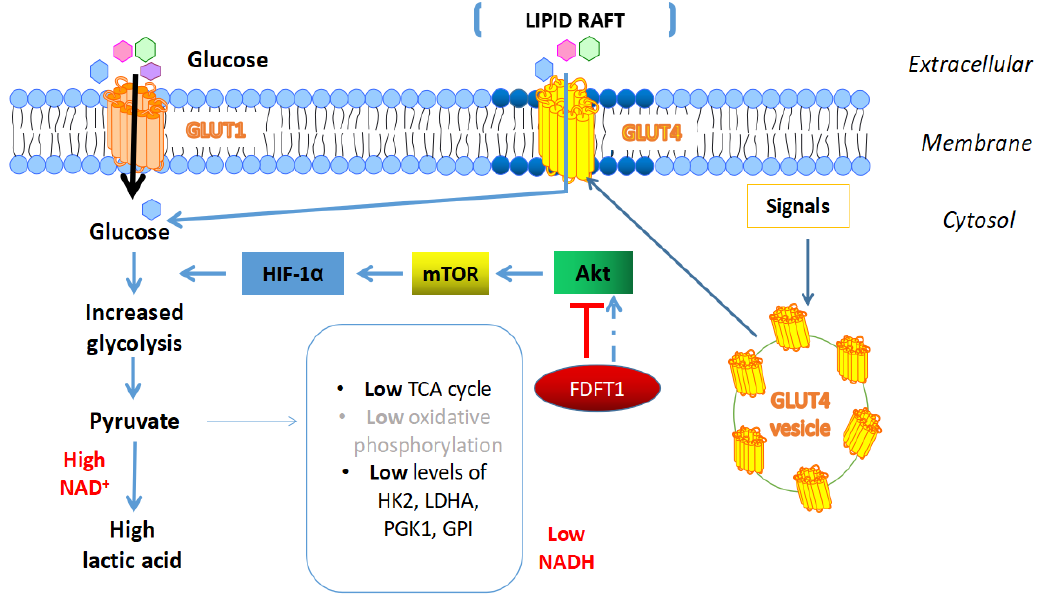
Figure 5. Association FDFT1 with metabolism in cancer. FDFT1 increases cholesterol in membrane microdomains, and thus traffics GLUT4 from the cytosol to lipid rafts in the cell membrane, consequently enhancing glucose uptake from TME into cells. On the other hand, FDFT1 has been determined to inhibit the Akt/mTOR/HIF-1 α axis, thereby decreasing expression of glycolytic enzymes such as HK2, LDHA, PGK1, GPI, and ultimately, reducing the lactic acid concentration in the TME. However, this mechanism has only been shown in colorectal cancer [7] , and it will be necessary, therefore, to determine whether FDFT1 could inhibit or activate Akt/mTOR/HIF-1 α signalling in other cancers.